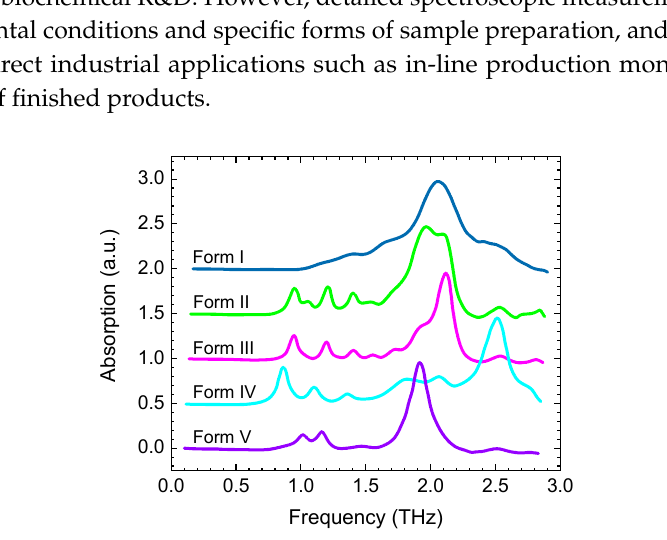
Figure 13. Terahertz absorption spectra of the five polymorphic forms of sulfathiazole (vertically offset and normalized for clarity). Adapted from [81].